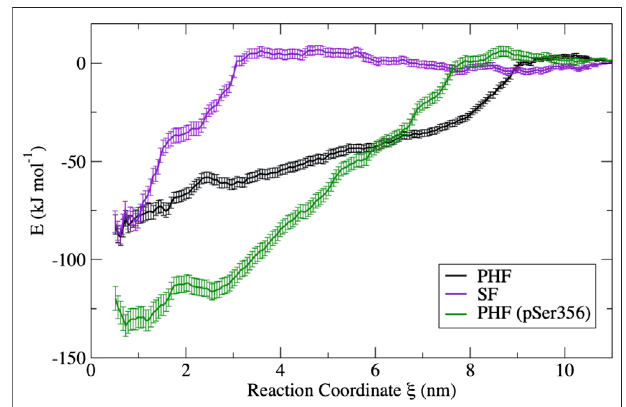
FIGURE 3 | Free energy curves obtained from umbrella sampling simulations for each fi bril in this study. The PHF free energy pro fi le (black) and theSF freeenergypro fi le (violet)have asimilar freeenergy minimum;however, the different shape re fl ects a different dissociation mechanism. The PHF fi bril is stabilized by phosphorylation at Ser356 (green) despite having a similar mechanism of dissociation. Error bars were determined by